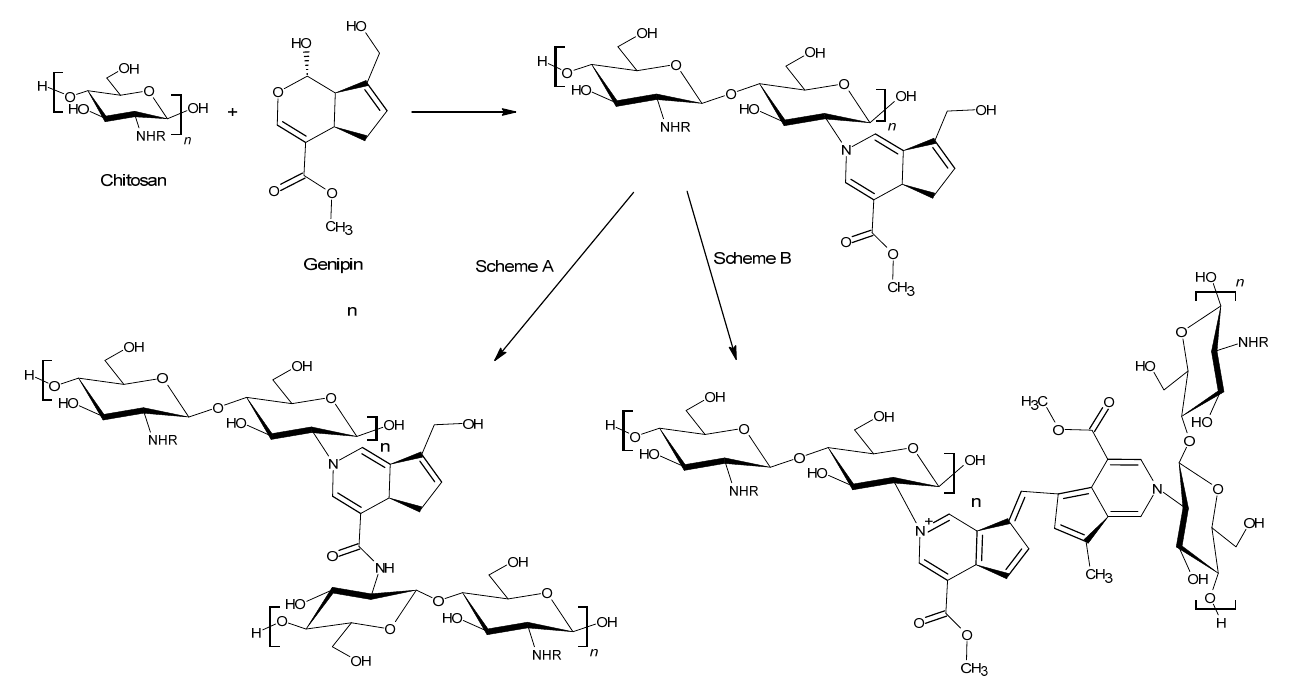
Polymers 2021 , 13 , 4031 Figure 3. Covalent cross-linking reaction between chitosan and genipin . Figure 3. Covalent cross-linking reaction between chitosan and genipin.